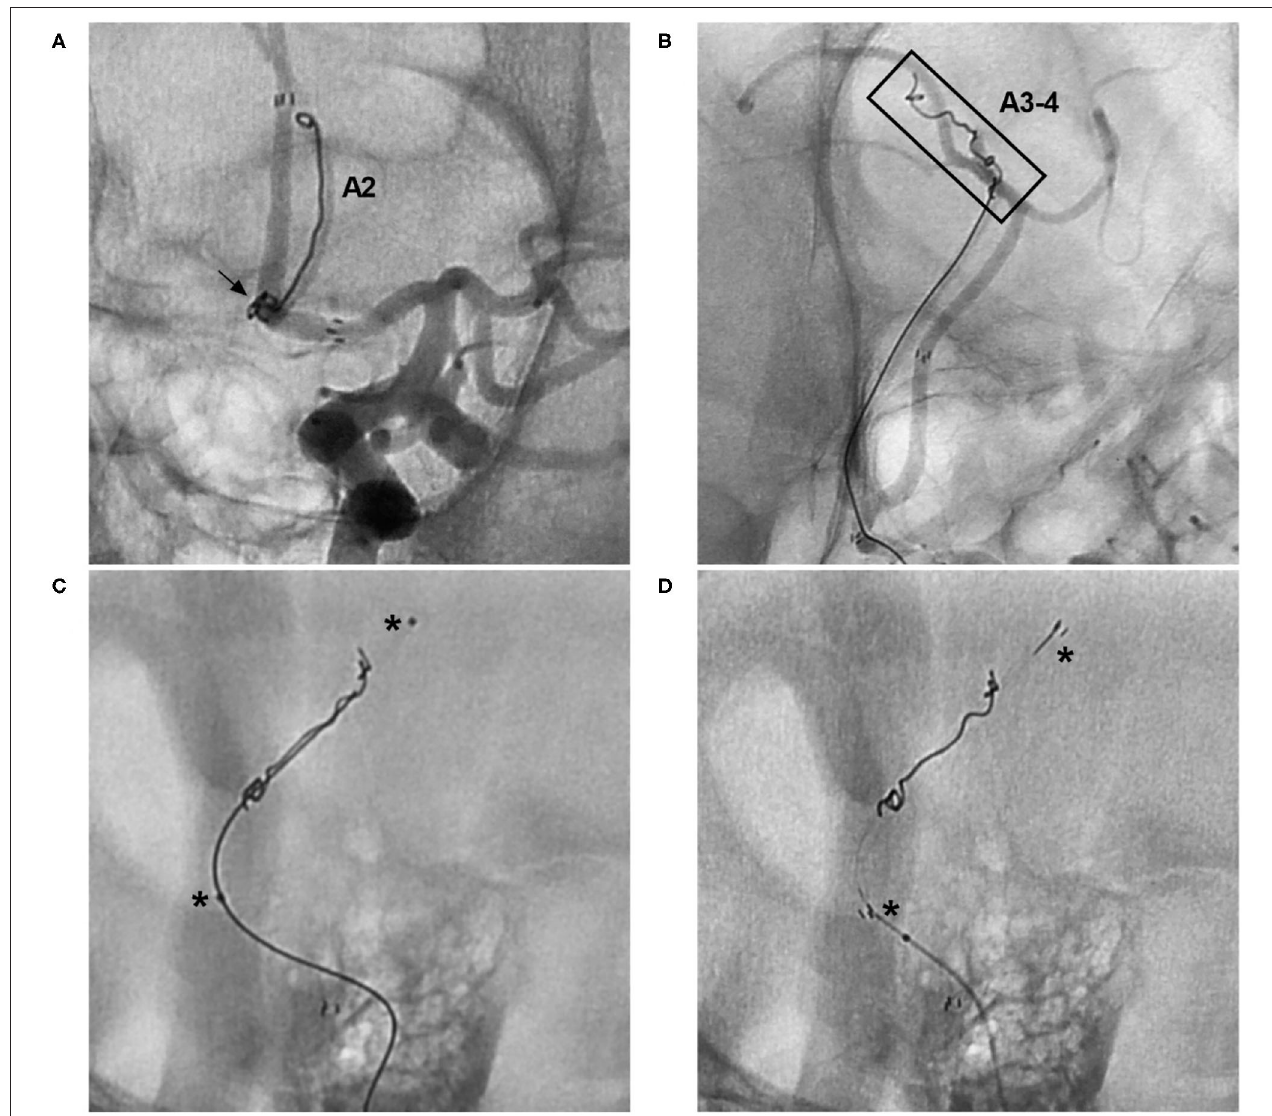
FIGURE 11 | Rescue stenting with the NAS to address coil migration. (A) Unsubtracted DSA of the ICA showing coil protrusion from an AcomA aneurysm (arrow) into the A2 segment. (B) Unsubtracted DSA of the ICA showing coil protrusion from an AcomA aneurysm reaching the A3-4 segment (frame). (C) Unsubtracted DSA showing crossing of the coil by an XT-17 microcatheter; the asterisks indicate two markers of the microcatheter. (D) Unsubtracted DSA showing crossing of the coil by the NAS; the asterisks indicate the proximal and distal markers of the NAS. A2, second segment of the anterior cerebral artery; A3-4, third and fourth segments of the anterior cerebral artery; AcomA, anterior communicating artery; DSA, digital subtraction angiography; ICA, internal carotid artery; NAS, Neuroform Atlas